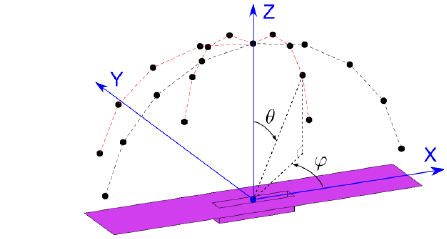
Figure 7. Microphone positions.